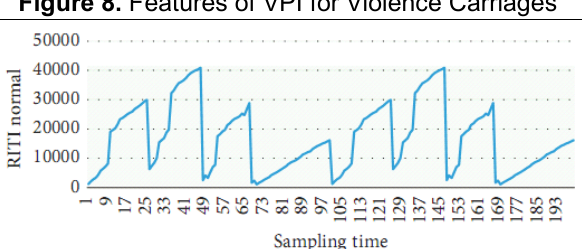
Figure 8. Features of VPI for Violence Carriages